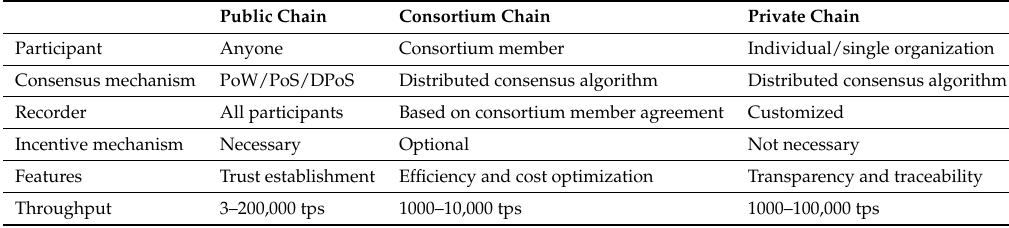
Table 1. Comparison of different types of